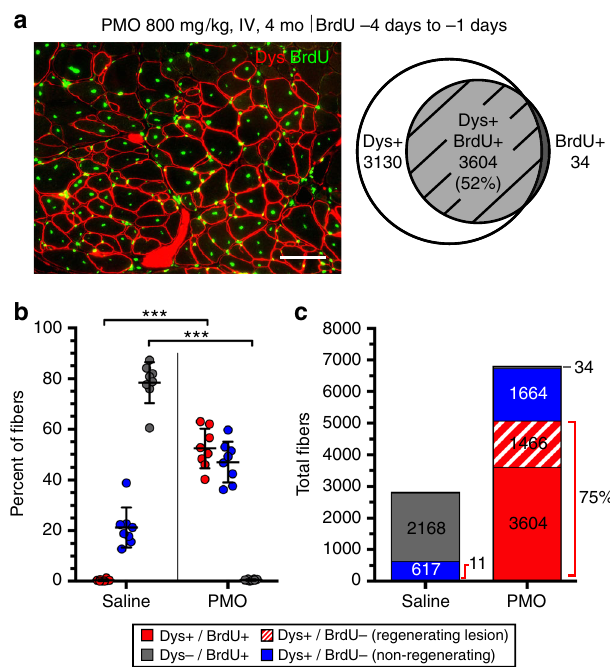
Fig. 3 PMO entry of regenerating myo fi bers in mature mdx mice. a Dystrophin expression speci fi c to BrdU +ve regenerated myo fi bers in aged mdx muscle (triceps, gastrocnemius, and quadriceps) following a single IV dose of PMO (800 mg/kg, n = 3) at 13 weeks of age in conjunction with BrdU administered for 72h prior to PMO delivery. Dystrophin expression (Dys, red ) and BrdU +ve central myonuclei ( green ) 14 day after PMO to evaluate dystrophin restoration relative to muscle regeneration. Venn diagram demonstrates the overlap between dystrophin expression (Dys +ve ) and myo fi ber regeneration (BrdU +ve ). Scale bar represents 100 μ m. b Quanti fi cation of Dys +ve /BrdU +ve , Dys +ve /BrdU − ve , and Dys − ve /BrdU +ve myo fi bers shown as a percentage of labeled fi bers. Data represented as scatter plot with SD. c Quanti fi cation of labeled fi bers classi fi ed as Dys +ve /BrdU +ve ( red ), Dys +ve /BrdU − ve within a regenerating lesion ( dashed red ), Dys +ve /BrdU − ve ( blue ), or Dys − ve /BrdU +ve ( gray ) ( n = 4). Statistical analysis performed by Mann – Whitney nonparametric test; *** p <